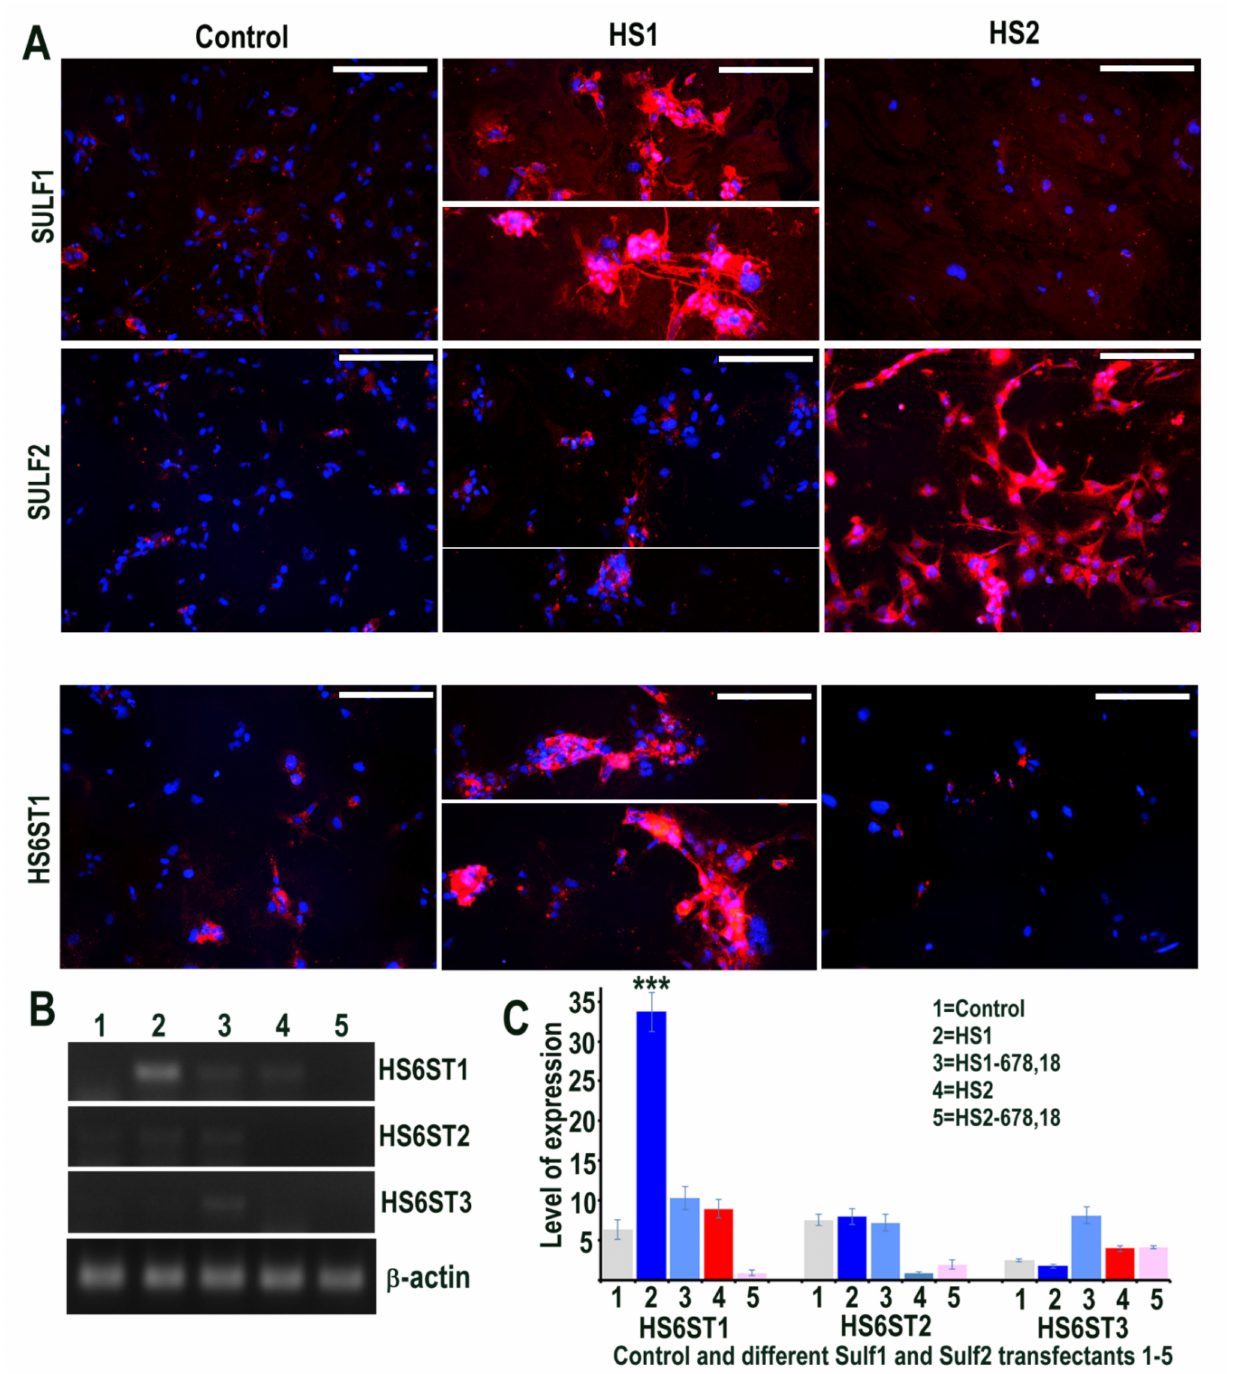
Figure 1. ( A ) Levels of Sulf1 and Sulf2 protein expression in HMec1 cells transfected with pcDNA3 (control) and Sulf1 (HS1) and Sulf2 (HS2) genes examined by antibodies to SULF1 and SULF2 using immunofluorescence procedure including the changes in the levels of HS6 sulfotransferase 1 following such transfections. Scale bar = 100 µ M. ( B , C ) Selective changes in the levels of HS6ST1, HS6ST2 and HS6ST3 were also examined using RT PCR analysis and quantified using Image J analysis. Error bars = means ± SD; *** p <